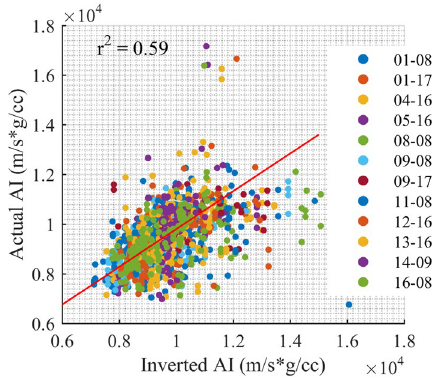
Fig. 5 Cross-plot of inverted impedance with the actual impedance for all the well logs. The distribution of scatter points depicts perfor- mance of the